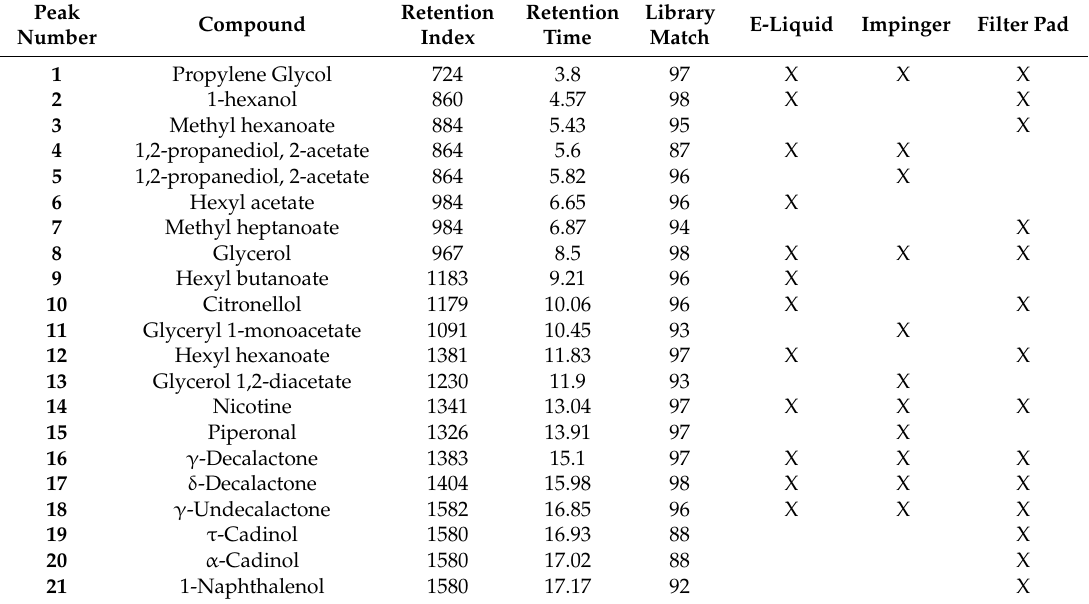
Figure 2. Gas chromatogram (GC) analysis of aerosol emissions resulting from mango flavored e-liquid using alternative captured methods. Emissions were collected from 100 puffs under realistic topography conditions. Chromatograms reflect ( A ) e-liquid diluted in methanol, and emissions collected: ( B ) with series impinger 1; and ( C ) on 10 Cambridge pads, with 10 puffs per pad. Table 3. GC-MS analysis of molecules in observed in aerosols generated from 100 puffs of mango flavor e-liquid, in emissions captured with pads, and two series impingers.